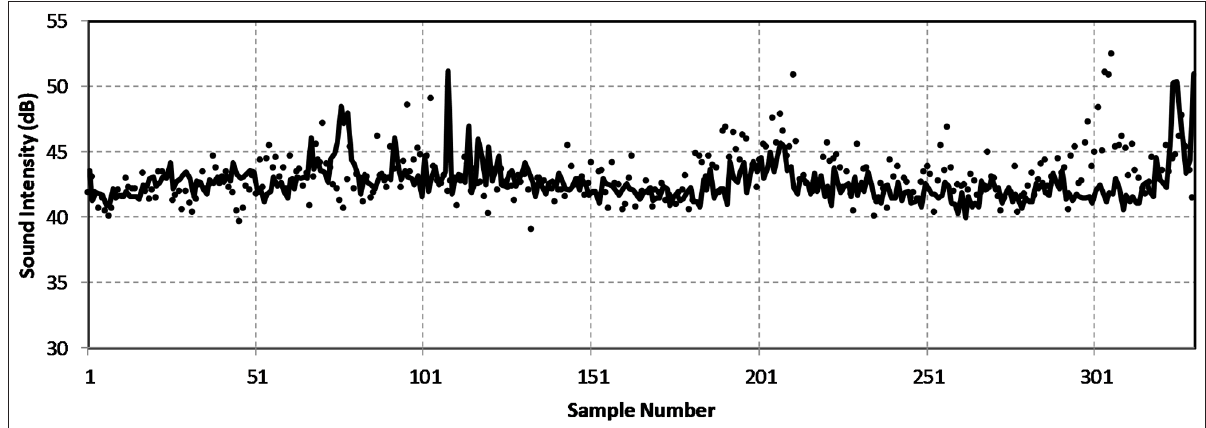
Figure 6: Quiet environment data for Decibel 10 th comparison. Solid curve is the Samsung Note 5 and dots are the iPhone 6s. Sampling interval is 0.2 seconds.